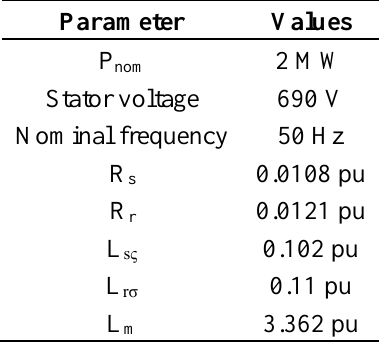
Table 3. Generator parameter